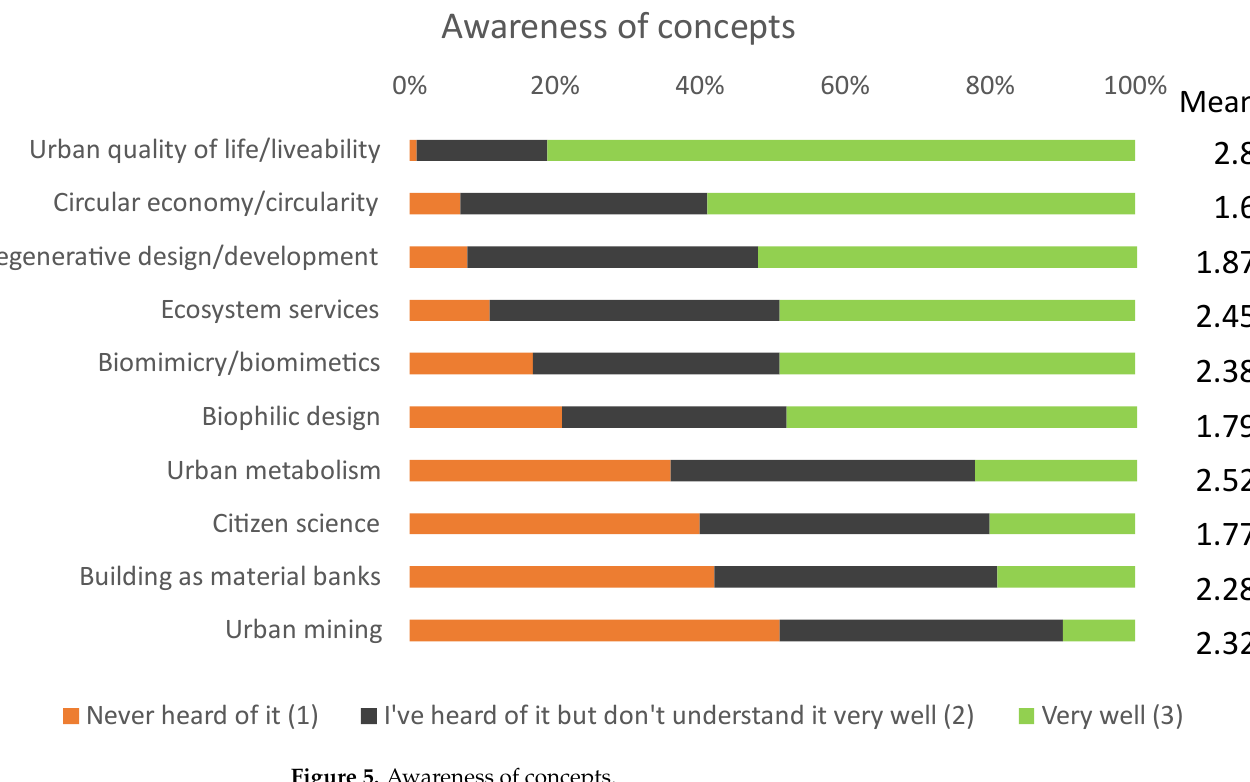
Figure 5. Awareness of